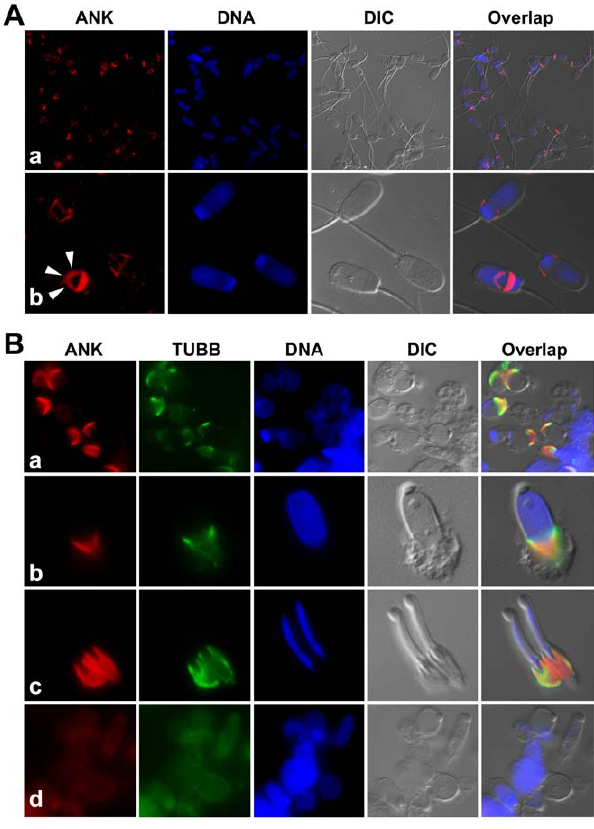
Figure 9. Immunofluorescence of ANKH (red) in boar sperma- tozoa (A) and spermatids (B). (A) Prominent labeling is present in the postacrosomal sheath, and in the equatorial segment (arrowheads in panel b) of ejaculated spermatozoa. (B) During spermiogenesis, ANKH colocalizes with tubulin (TUBB, green) in the microtubules of the spermatid caudal manchette (a–c) at all steps of spermatid elongation during which the manchette is present (late round/early elongating spermatid-a; late elongating spermatid-b & c; top and side view-d, respectively). This pattern is typical of the deposition of proteins into postacrosomal sheath that serve a structural or metabolic/signaling purpose in fully differentiated spermatozoa. Microtubules were labeled with monoclonal antibody against tubulin beta (TUBB). DNA was counterstained with DAPI (blue). Epifluorescence micrographs were overlaid with parfocal transmitted light photos acquired with DIC optics.